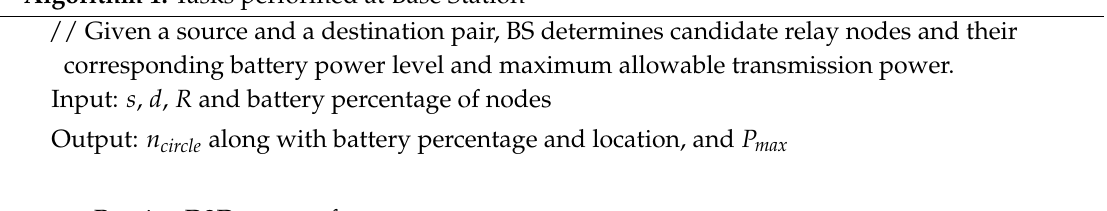
Algorithm 1: Tasks performed at Base Station // Given a source and a destination pair, BS determines candidate relay nodes and their corresponding battery power level and maximum allowable transmission